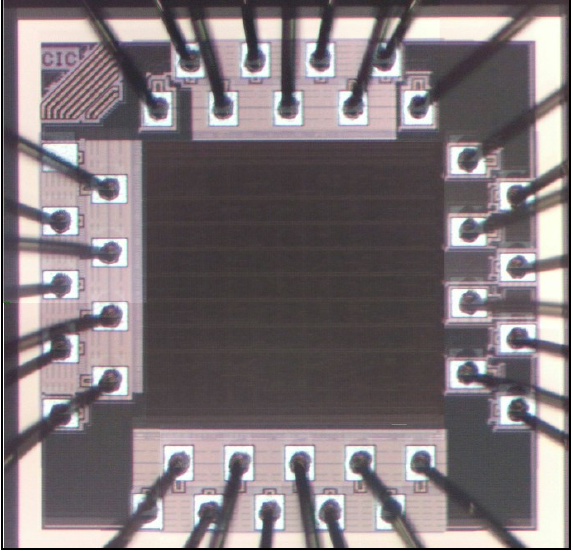
Figure 22. Photomicrograph of the proposed MPDTC ASIC.